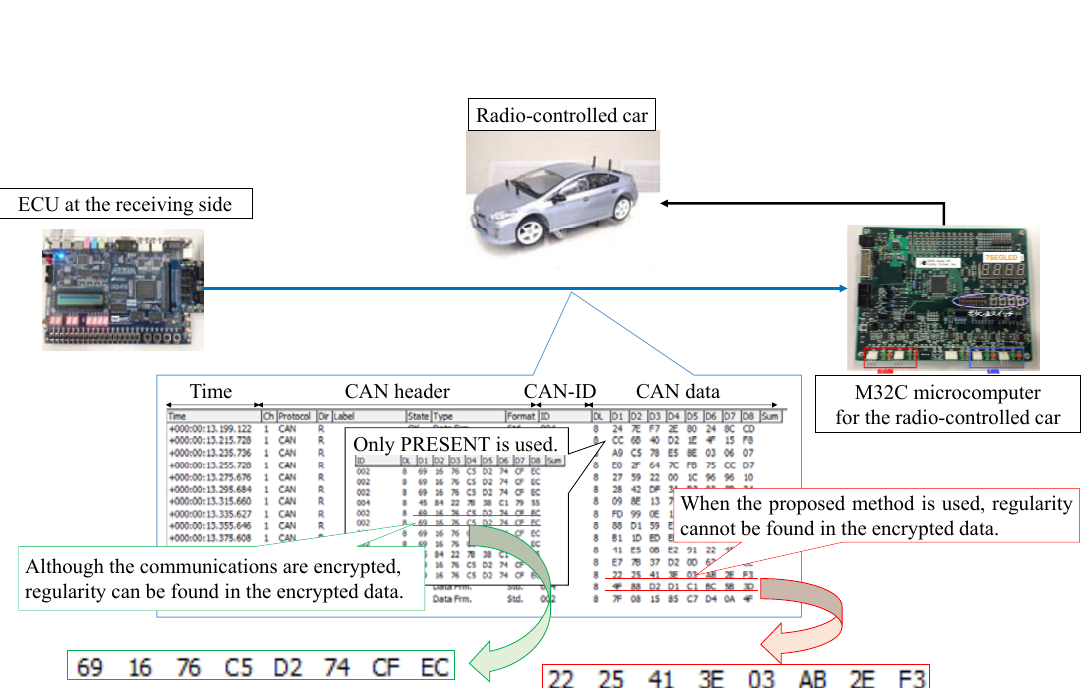
Fig. 9. Observed data (Proposed CAN communications without